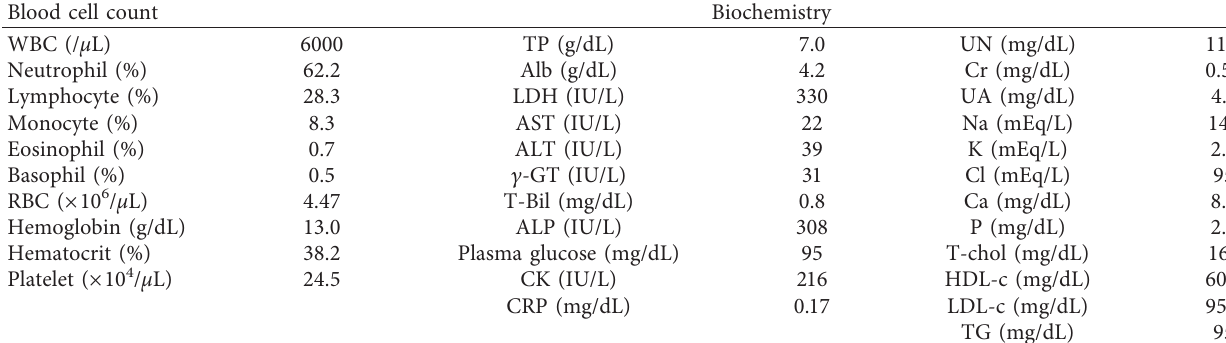
Table 1: Laboratory findings.